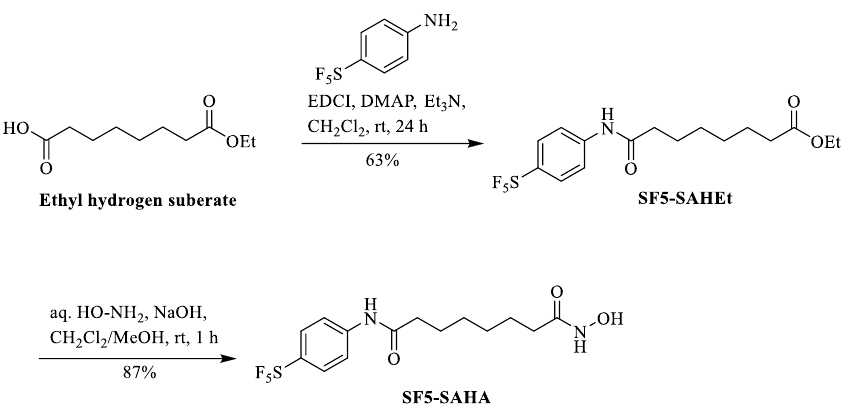
Scheme 1. Synthesis of SF5-SAHA.